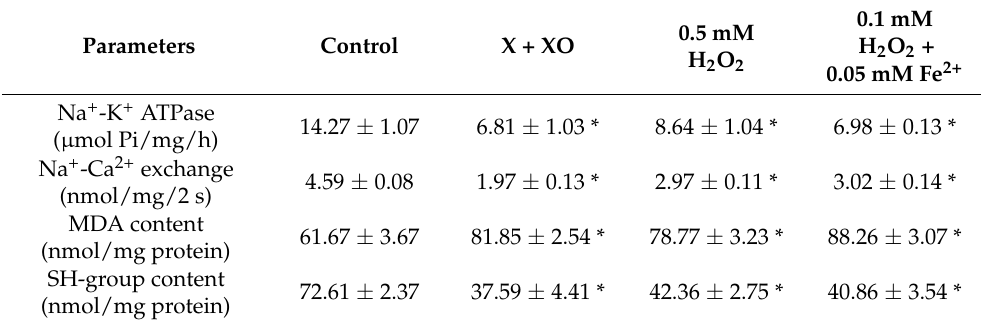
Table 1. Modification of Na + -K + ATPase and Na + -Ca 2+ exchange activities as well as malondialde- hyde (MDA) and sulfhydryl (SH-group) content of cardiac sarcolemma upon incubation for 30 min with or without different oxyradical generating systems.